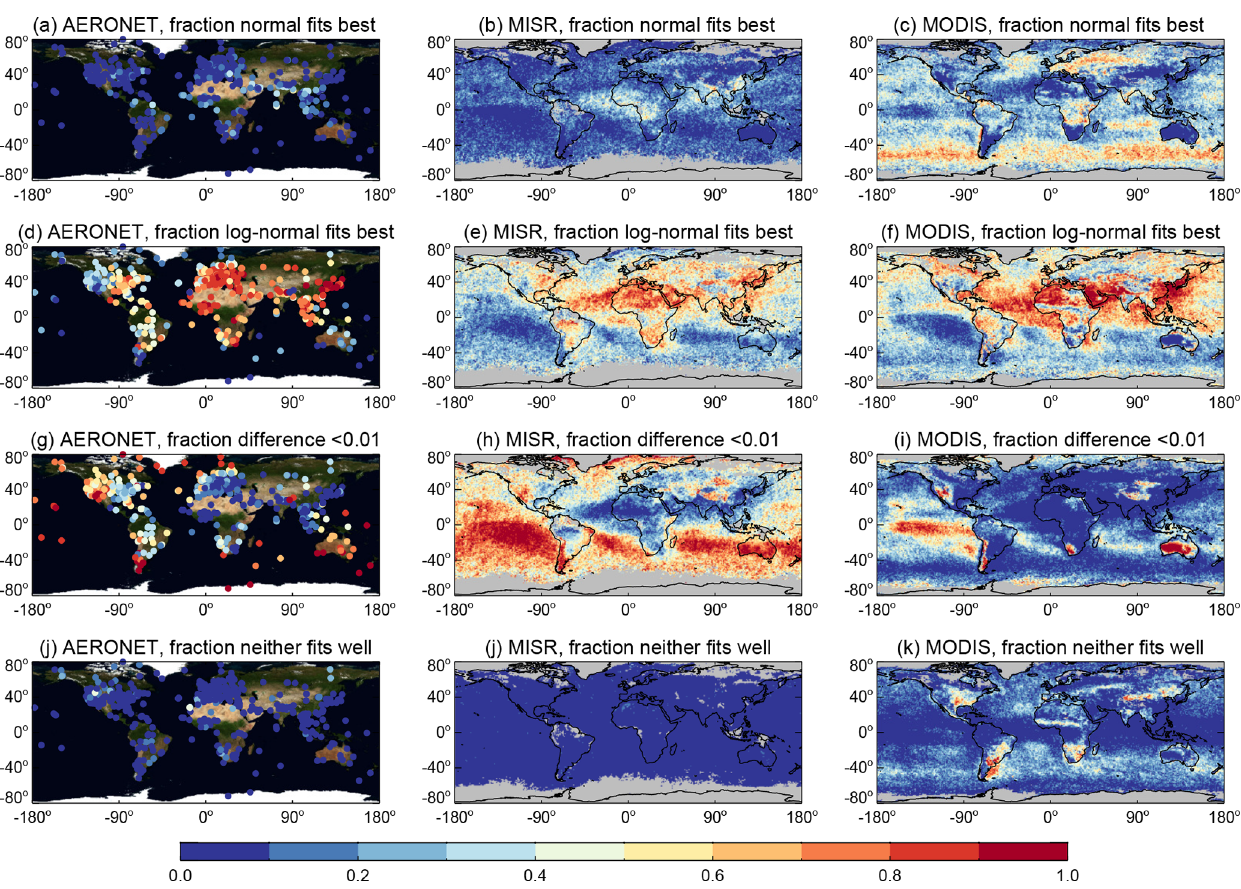
Figure 8. As in Fig. 3 except for AOD distributions aggregated temporally from daily to seasonal. Columns show (left) AERONET, (middle) MISR, and (right) MODIS data. At least eight contributing seasons are required for an AERONET site or grid cell to be valid; grid cells with insufficient data are shaded in